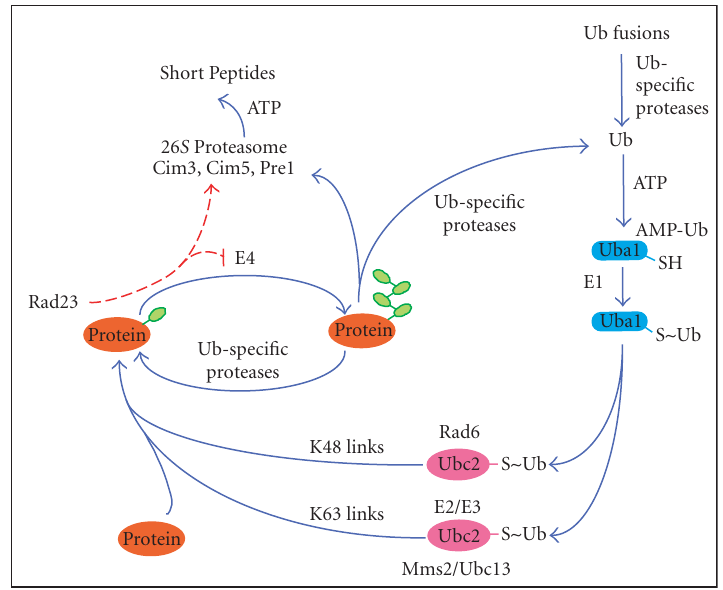
Figure 2. The yeast ubiquitin-mediated protein degradation pathway (adapted from [49]). The Ubiquitin (Ub) System is a multienzyme process that cova- lently links Ub to a wide variety of intracellular proteins. Ub is expressed as a fusion with specific ribosomal proteins or as polyubiquitin fusions. Ub-specific proteases generate free Ub that is activated by a Ub-activating (E1) enzyme, in an ATP-dependent reaction. Ub is transferred from E1 to Ub-conjugating (E2), and Ub (E3) ligase enzymes through a series of transesterification reactions, and is finally ligated to lysine residues in the target protein. This last step might require a ubiquitin-protein (E3) ligase. The specificity of the system resides in the E2 and E3 enzymes. Newly identified E4 enzymes may regulate the assembly of multiubiquitin chains on